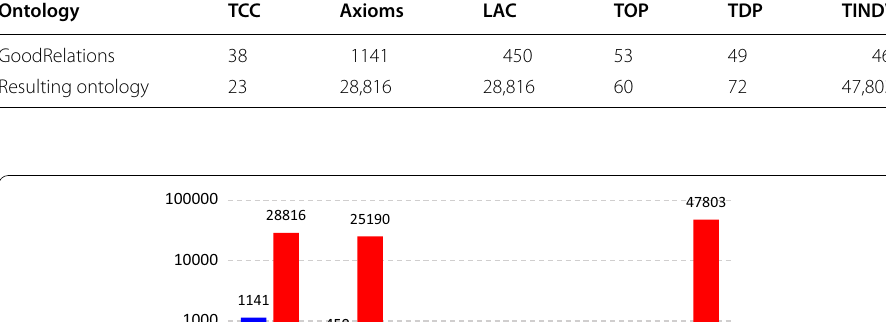
Table 8 The basic metrics of the GoodRelations versus the resulting ontology Ontology TCC Axioms LAC TOP TDP TINDV GoodRelations 38 Resulting ontology